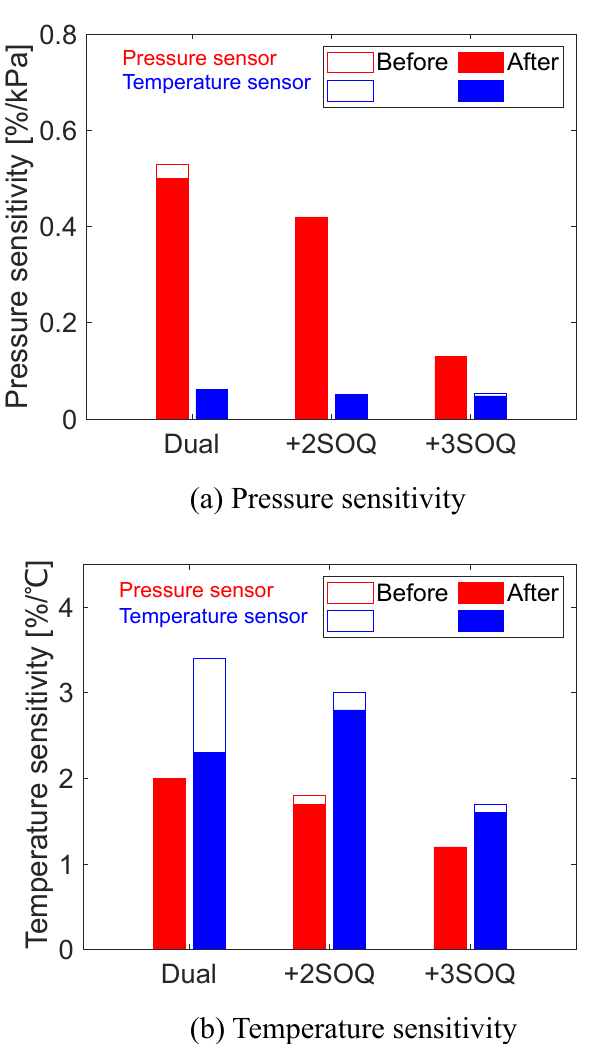
Figure 8. Pressure and temperature sensitivities before and after the aging